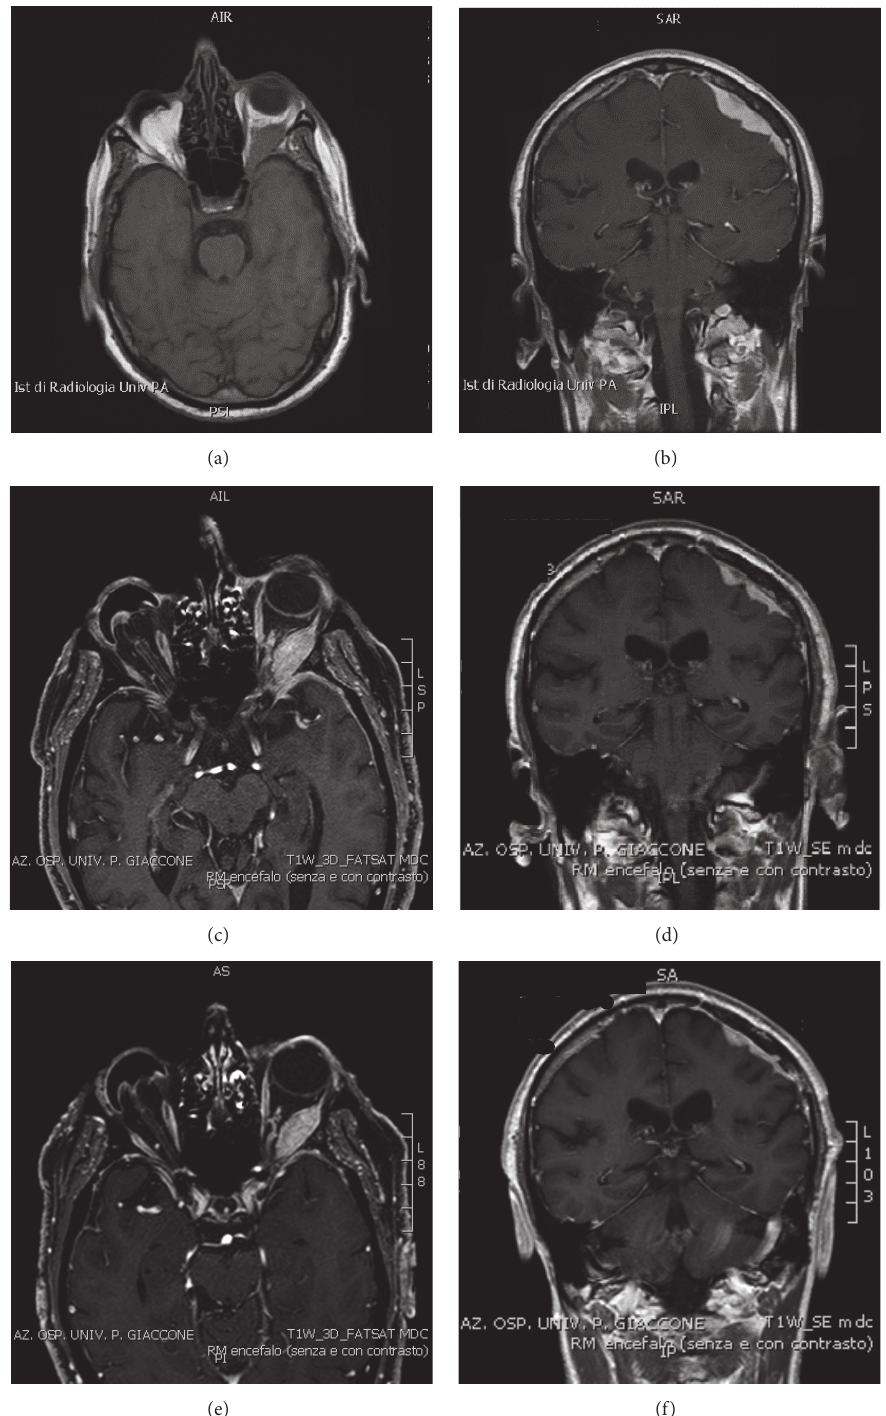
Figure 1: Axial (a, c, e) and coronal (b, d, f) enhanced T1 MR images reveal enhancing masses along the left frontoparietal-temporal region and the orbital region with dislocation of the optic nerve at onset (a, b) and in one-year (c, d) and two-year (e, f) follow-up,